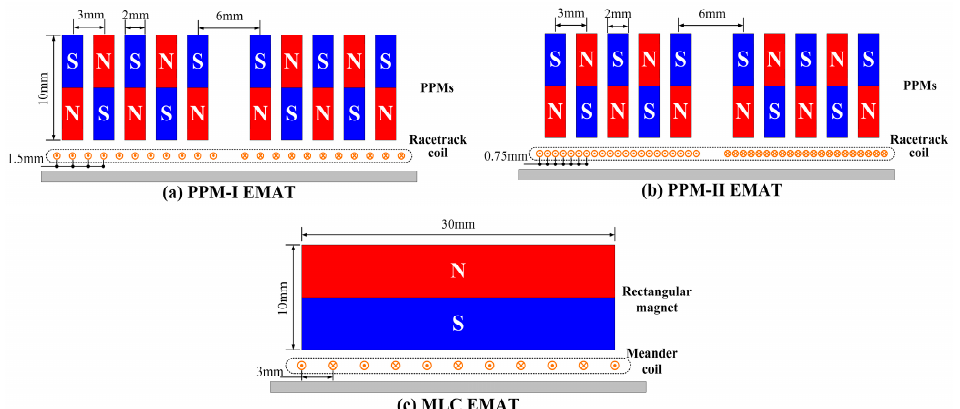
Figure 19. Structure diagram of developed PPM EMATs and conventional MLC EMAT. ( a ) PPM-I EMAT, the coil is a racetrack coil with wire spacing of 1.5 mm. ( b ) PPM-II EMAT, the coil is a racetrack coil with wire spacing of 0.75 mm. ( c ) MLC EMAT, the coil is a meander coil with wire spacing of 3 mm. Table 3. Dimensional parameters of coils in PPM and MLC EMATs.